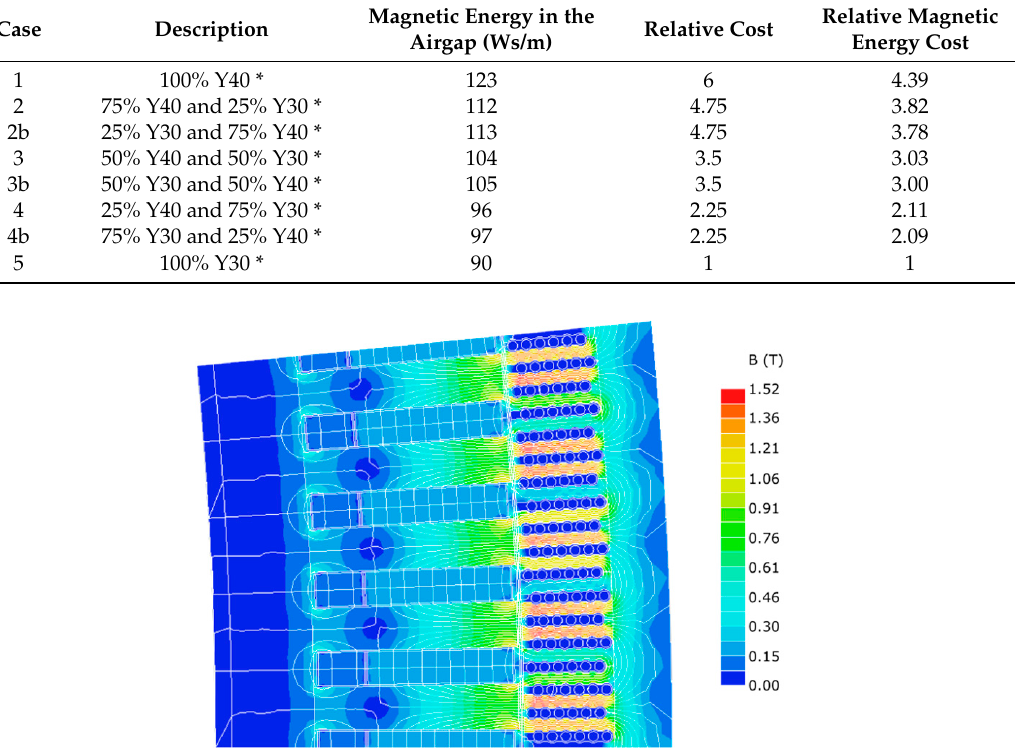
Figure 6. The magnetic energy per unit stack length in the airgap (Ws/m) for relative amount of Y40.